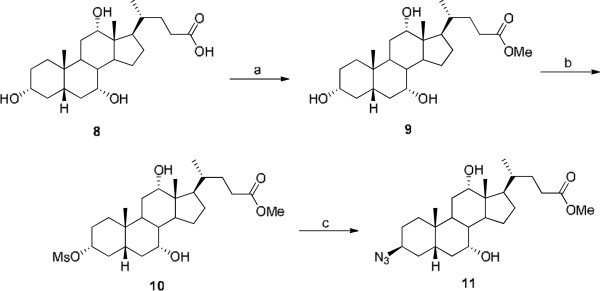
Reagents and conditions: (a) HCl/MeOH, 25°C, 24 h, 98%; (b) MsCl, Et3N, CH2Cl2, 0°C, 2 h, 80%; (c) NaN3, DMF, 120°C, 24 h, 70%.